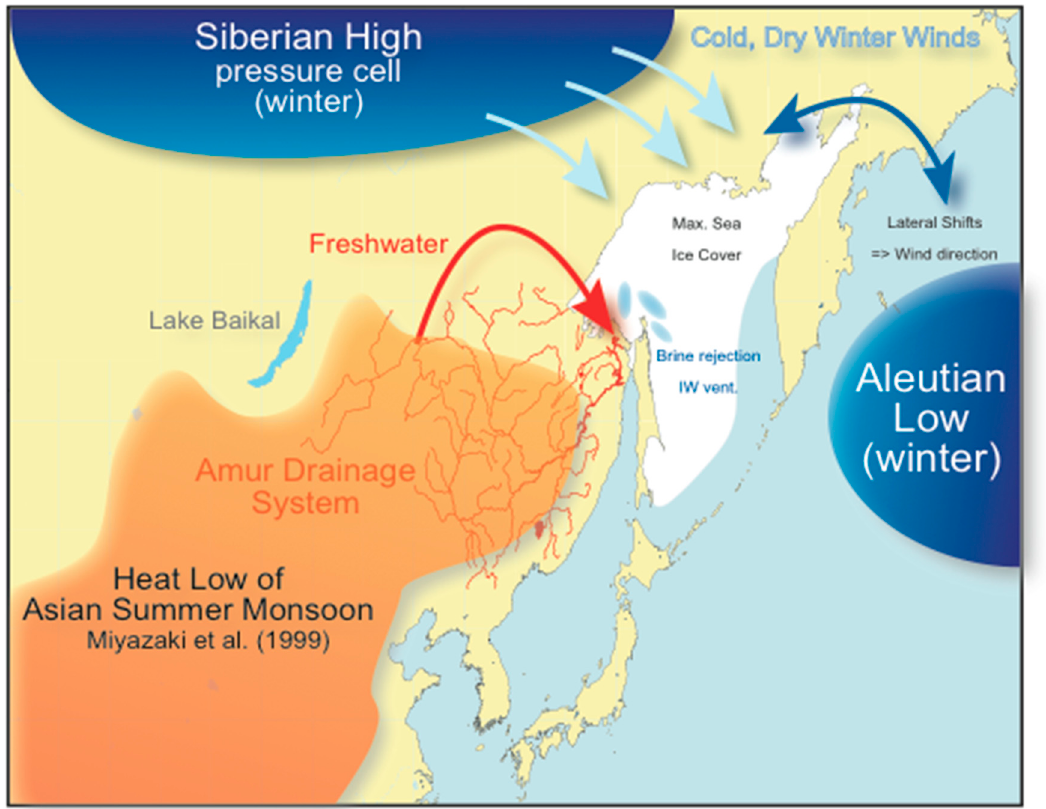
Figure 2. Schematic overview of forcing factors in the study area that influence sea surface temperatures and salinities, as well as mixed layer dynamics. This, in turn, determines the formation and ventilation rates of intermediate waters and the Pacific Meridional Overturning Circulation.